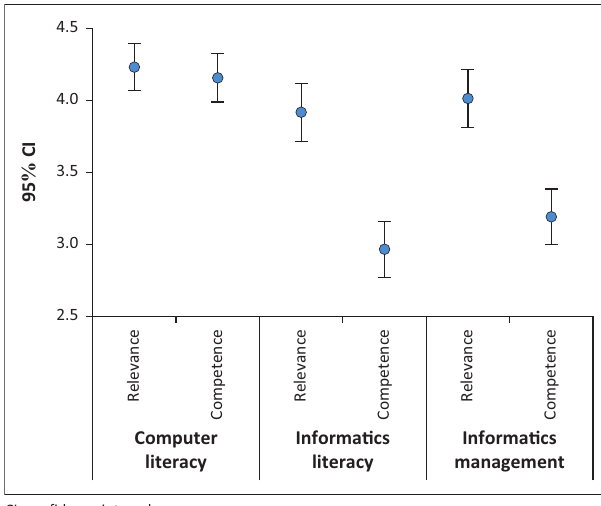
FIGURE 1: Average scores for nursing informatics